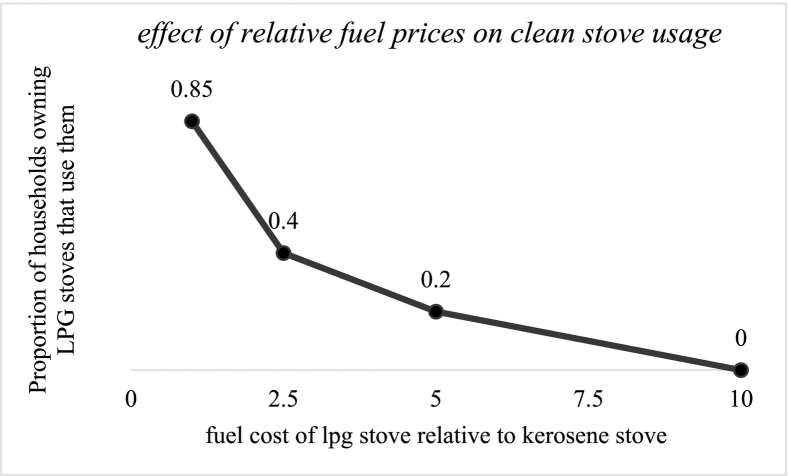
Effect of relative fuel prices on clean stove usage.